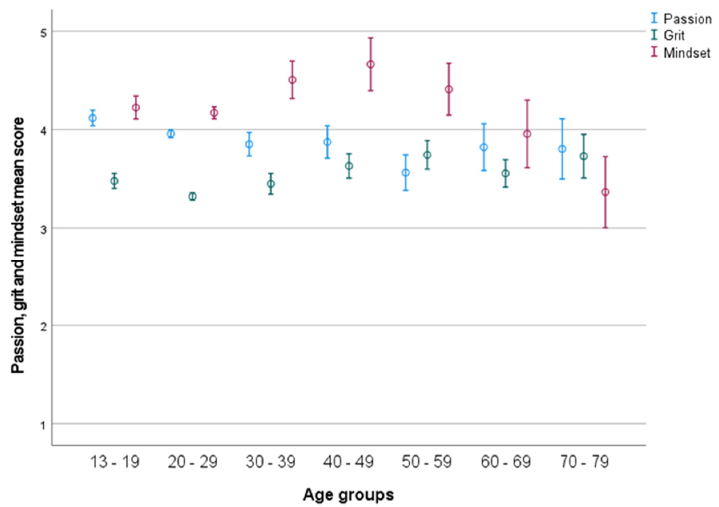
Figure 1. Passion, grit, and mindset across life-span in the seven age groups. Error bars represent 95 CI.